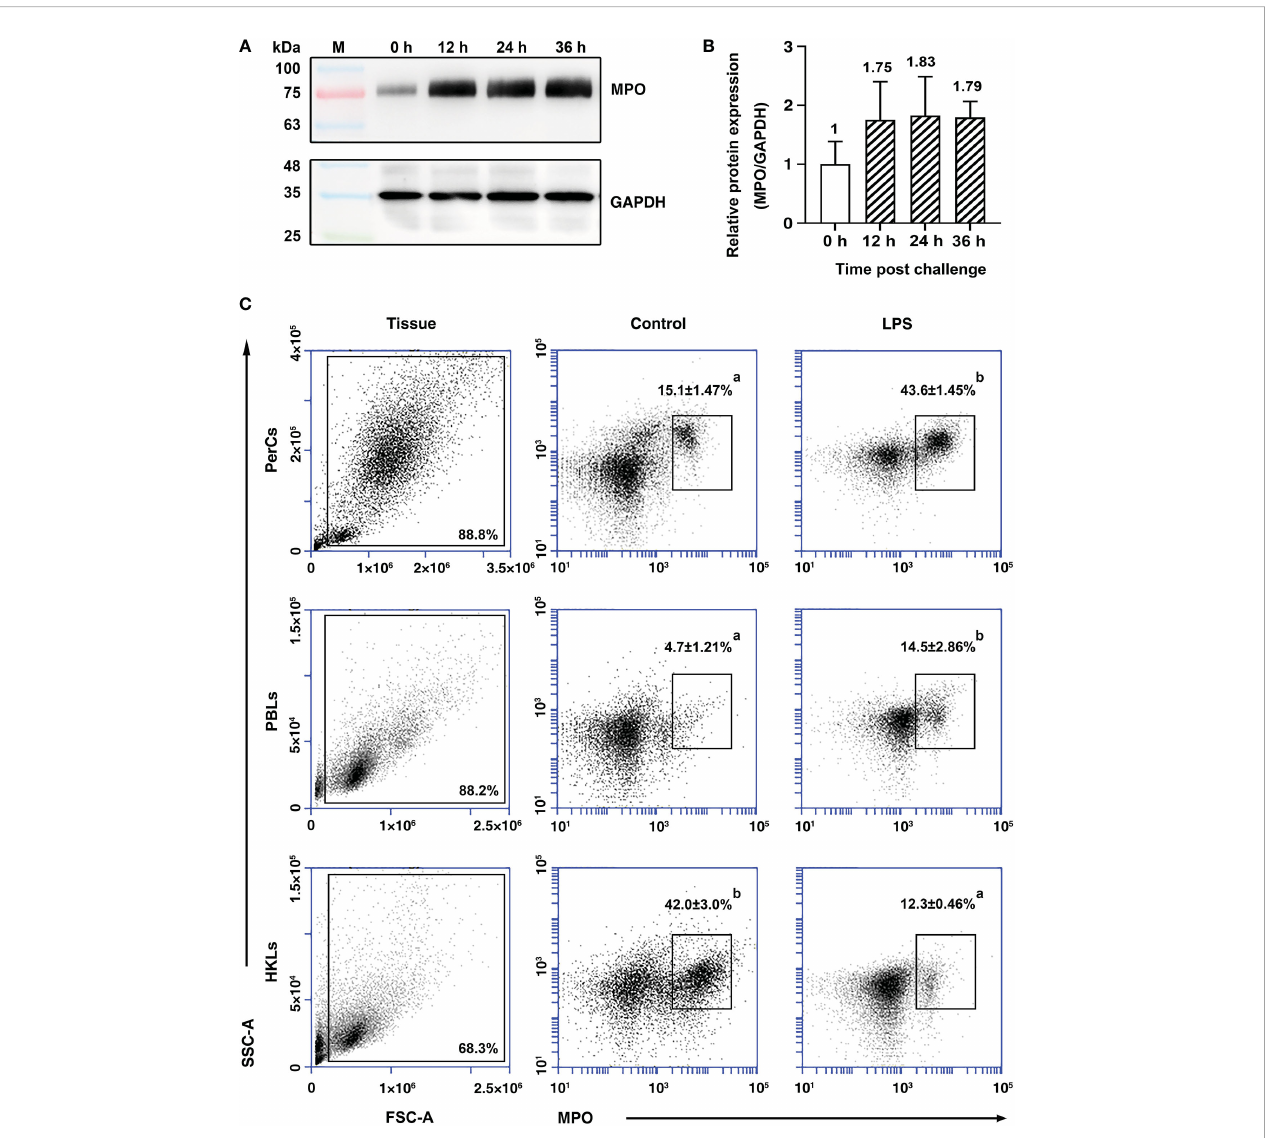
FIGURE 4 The expression of Po MPO in leukocytes at different time points upon LPS stimulation. (A) Cell lysates were harvested and subjected to Western blotting analysis using anti-r Po MPO and anti-GAPDH Abs and the semi ‐ quanti fi cation of Po MPO was shown (B) . (C) Flow cytometric analysis of MPO + peritoneal leukocytes in the gate of FSC area (FSC-A)/SSC area (SSC-A) of fl ounder. Data are representative from three independent experiments, and vertical bars represent the mean ± SD. Different letters represent the statistical signi fi cance ( p < 0.05) compared to each other at the same